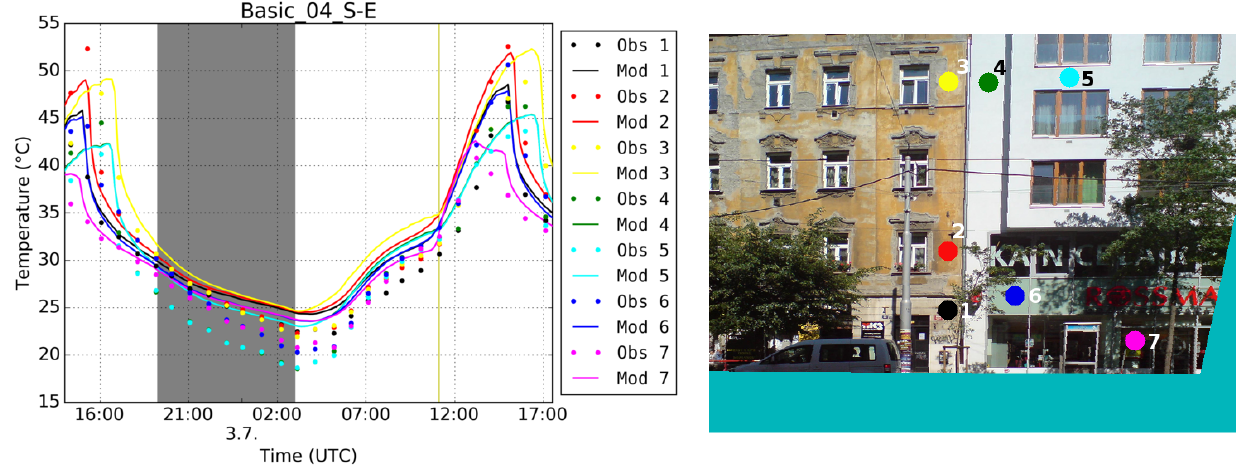
Figure 10. As for Fig. 9 for location 4 (50.10288 ◦ N, 14.44985 ◦ E) – view of the west-facing wall.